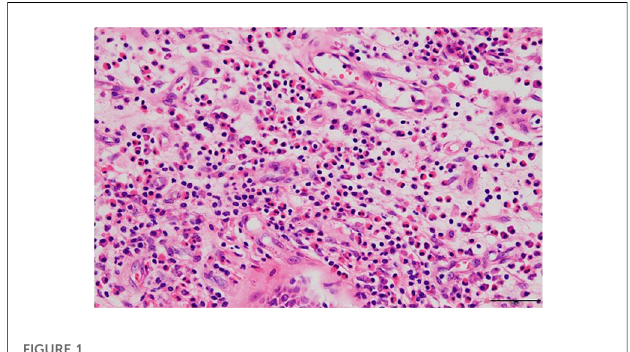
FIGURE 1 Hematoxylin and eosin-stained section of the nasal polyp (scale bar= 50 μ m). Marked eosinophil in fi ltration in the subepithelial area is